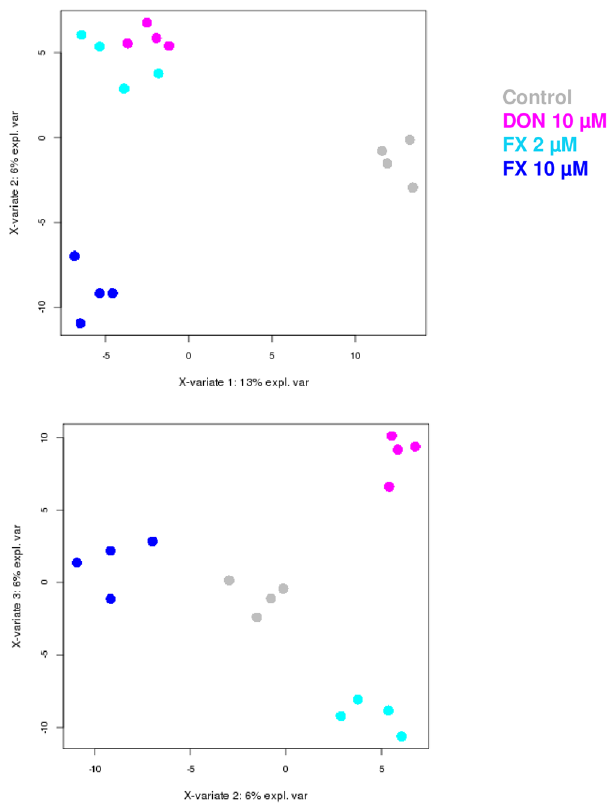
Figure 6. Scatter plots of the jejunal explant samples in the control, DON 10 µ M, FX 2 µ M and FX 10 µ M conditions using the first three components from the sPLS-DA analysis. Scatter plots were constructed using the first three hidden components selected by the sPLS-DA. These hidden components are obtained as linear combinations of the microarray probes using the estimated regression